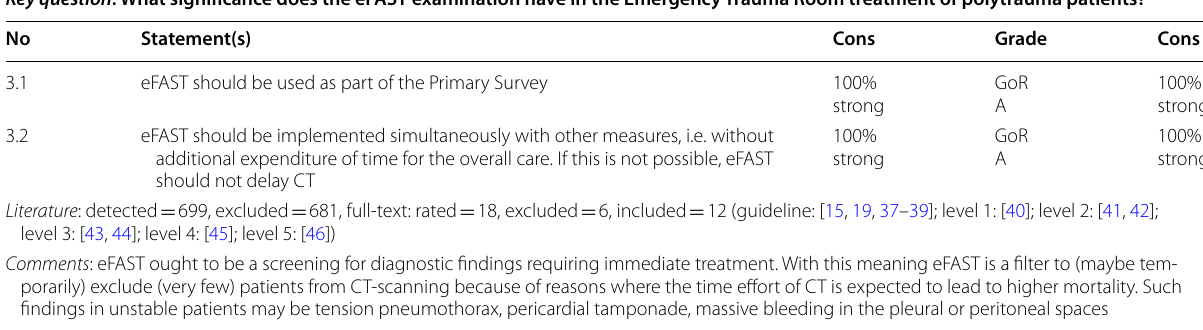
Table 6 Section 3: Extended Focused Assessment with Sonography for Trauma (eFAST)